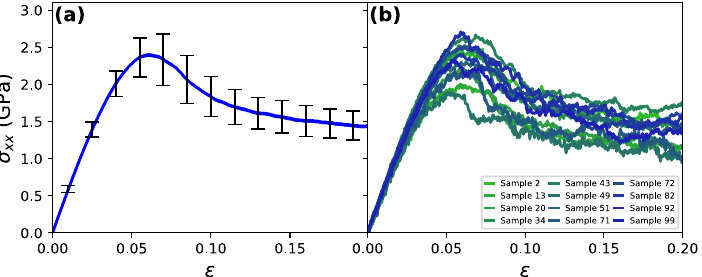
Figure 2. ( a ) Average stress–strain curves for the 100 samples. Standard deviations are denoted by the black bars. ( b ) Stress–strain curves of 12 samples were selected